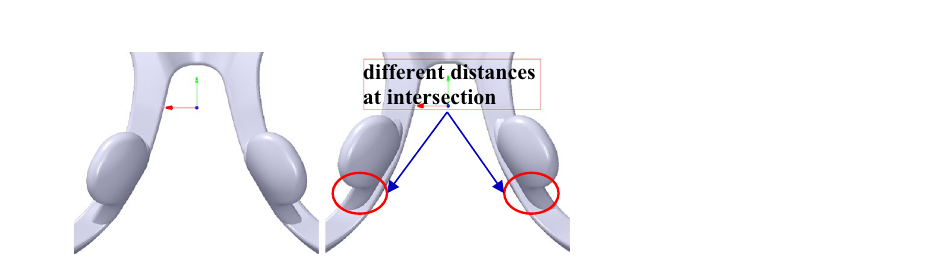
Figure 15. The frame rotation result. From left to right: the front view, the side view.